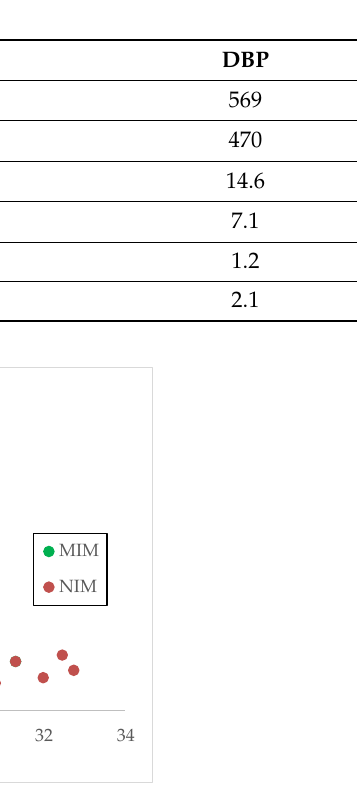
Figure 3. DEP sorption isotherms for resins molecularly imprinted membrane (MIM) and non- imprinted membrane (NIM) from series G.